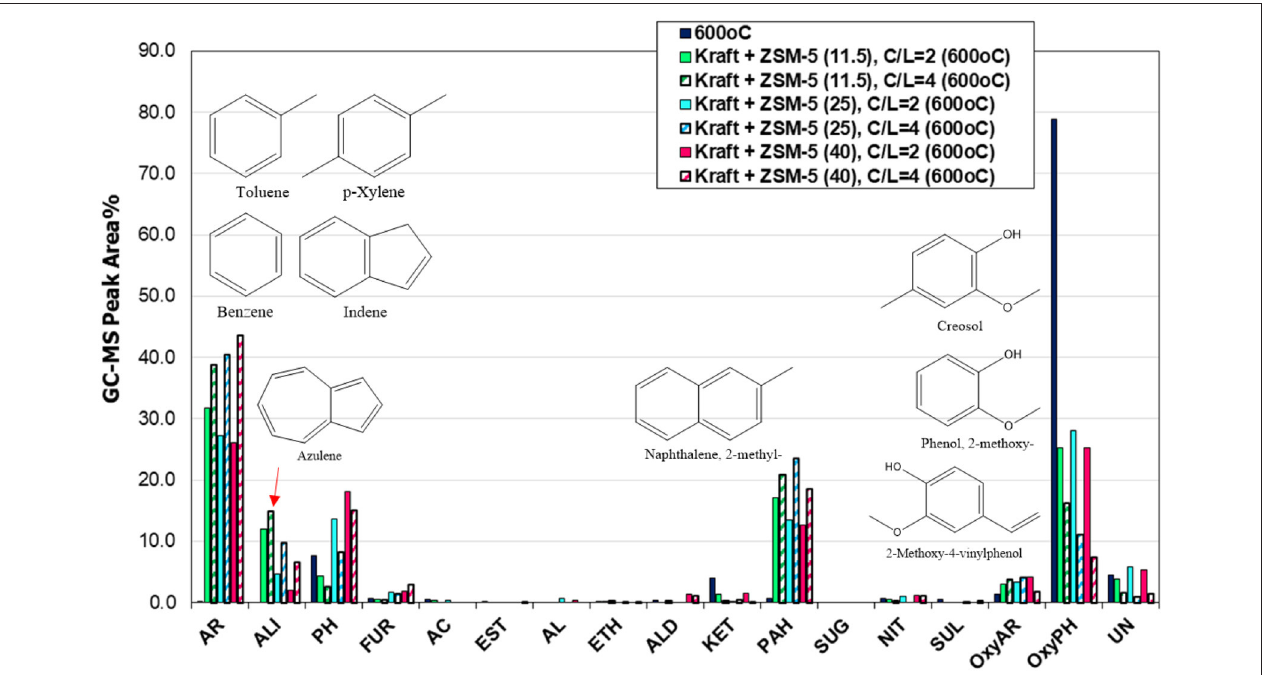
FIGURE 8 | Relative concentration of the various groups of compounds in the bio-oils derived by catalytic fast pyrolysis (CFP) of kraft lignin with ZSM-5 zeolites having different Si/Al ratio (11.5, 25, and 40) at 600 ◦ C and at different catalyst-to-lignin (C/L) ratios (2 and 4); indicated compounds in the graph are for ZSM-5 (11.5) at C/L = 4.